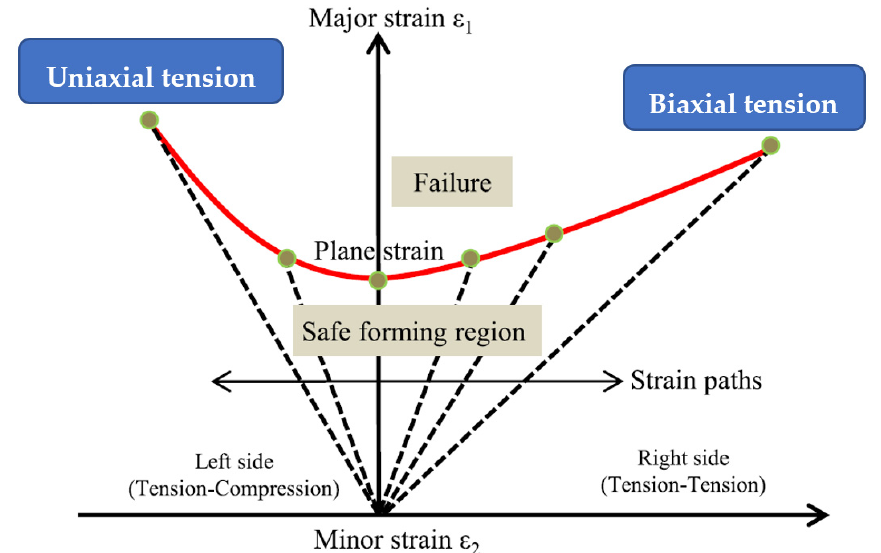
Figure 5. Strain paths for each specimen.